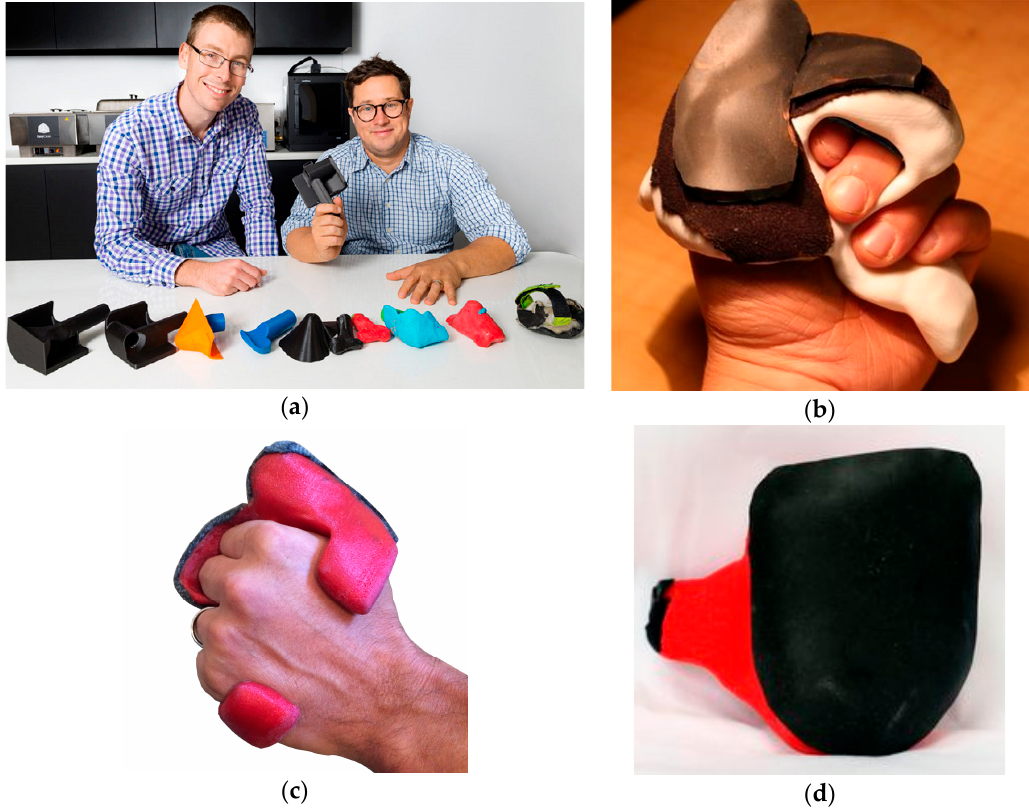
Figure 2. Existing types of wheelchair racing gloves: ( a , b ) customised solutions for professional athletes [1,2] and commercially available options; ( c ) 3D printed flexible rubber gloves based on specific finger and hand width measurements obtained with a soft measuring tape, available for CAD$295 (or GBP£170) [3]; ( d ) Flat-surfaced 3D printed glove based on specific measurements for thumb length and two-finger width, available for AU$220 (or GBP£114)